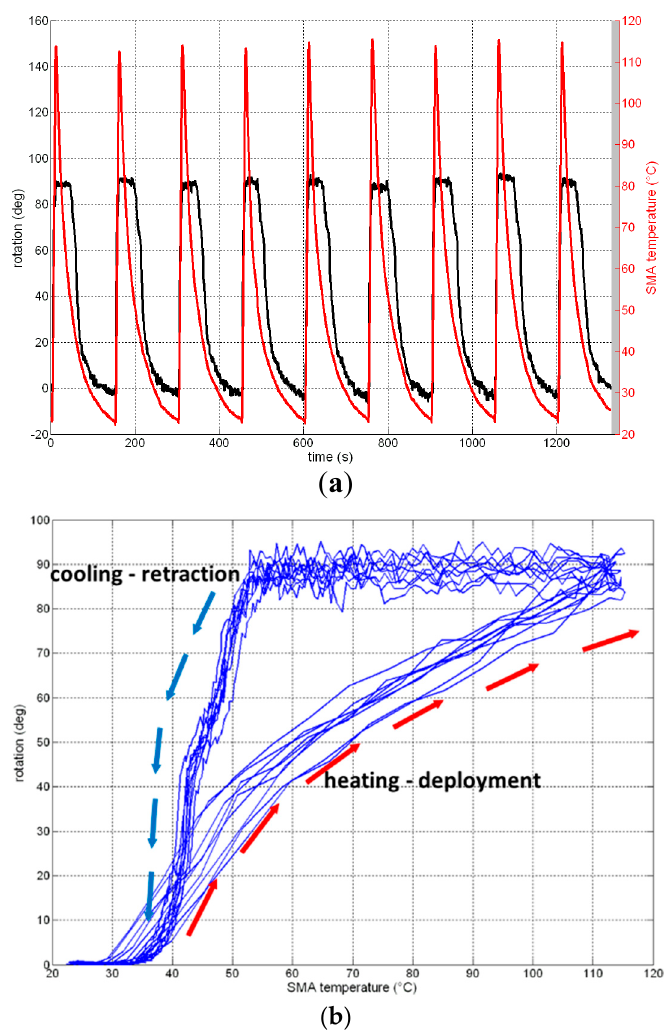
Figure 14. ( a ) Device rotation (red line, left axis) and temperature cycles (black line, right axis) vs. time (horizontal axis); ( b ) the blue curves in the plot on the right describe the evolution of the device rotation (left axis) vs. the temperature (right axis) and are reported for several activation cycles.